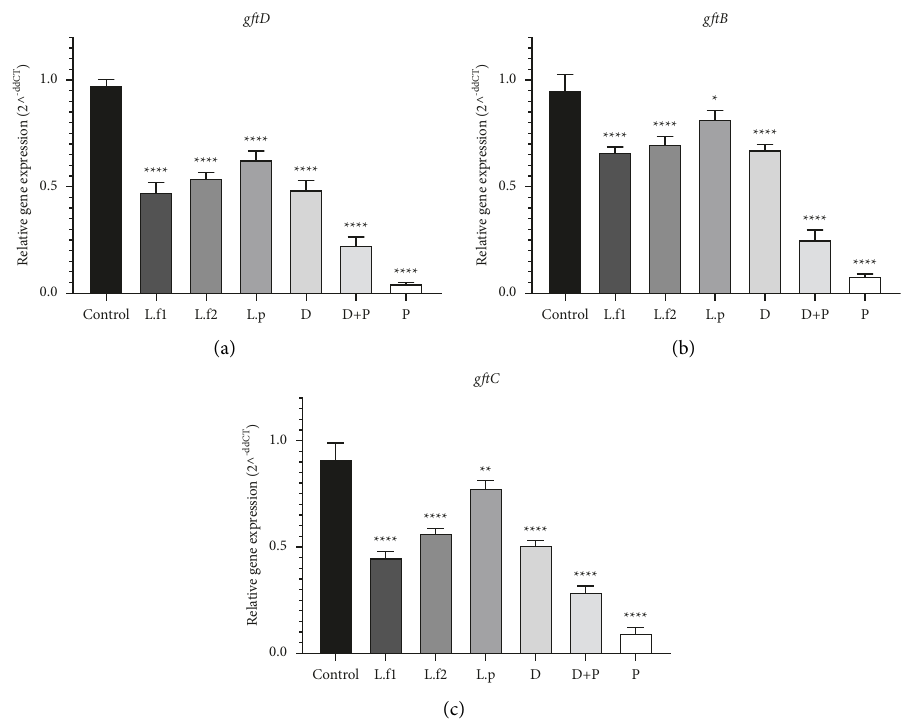
Figure 3: Evaluation of the effect of bacteriocins isolated from Lactobacillus fermentum 1 (L.f1), Lactobacillus fermentum 2 (L.f2), and Lactobacillus plantarum (Lp), the sum of all three bacteriocins isolated (D), the sum of all three bacteriocins isolated by lytic bacteriophage (P Specific ( D +P), and specific lithic bacteriophage (P) on the expression of native gtf gene. (a) gtfD, (b) gtfB, and (c) gtfC) of isolated Streptococcus mutans from decayed dental plaque. Comparison of gene expression level with control mode shows a significant reduction